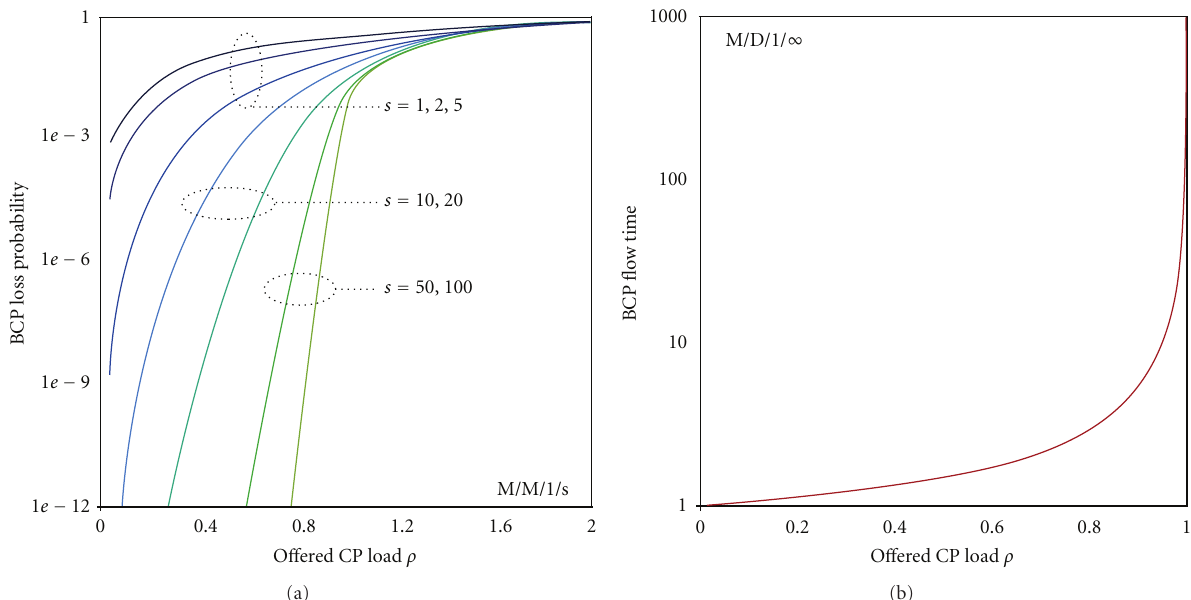
Figure 3: BCP loss probability for di ff erent system sizes (a) and BCP flow time (b) per OBS core node over normalized control plane (CP) load ρ = λ/μ .